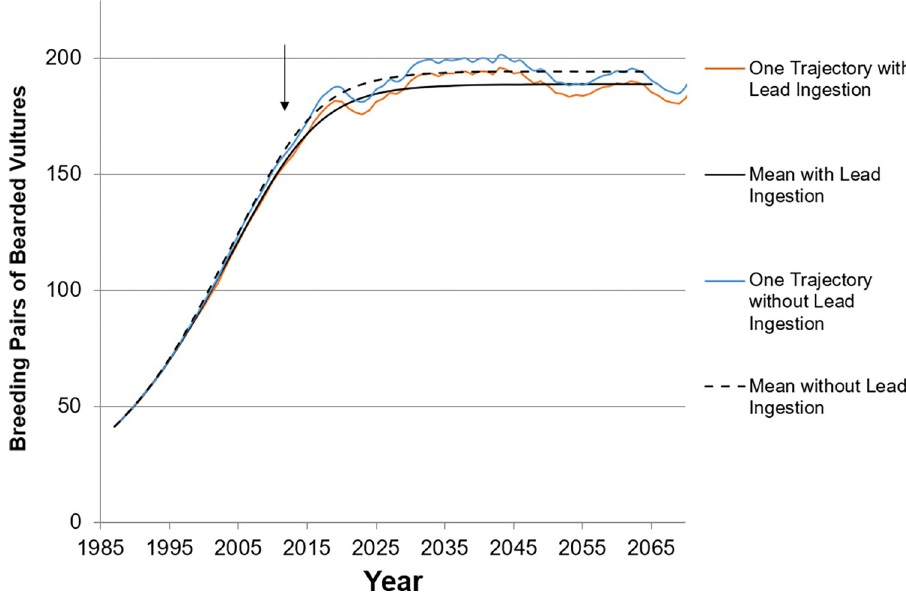
Fig 6. Modeled population trends for bearded vulture with and without lead shot and bullet ingestion. (a) Shown with reproduction effects. In addition to the mean, an example iteration of one of the 10,000 runs is shown in to demonstrate the trend variability. Analysis of lead effects began in 2012